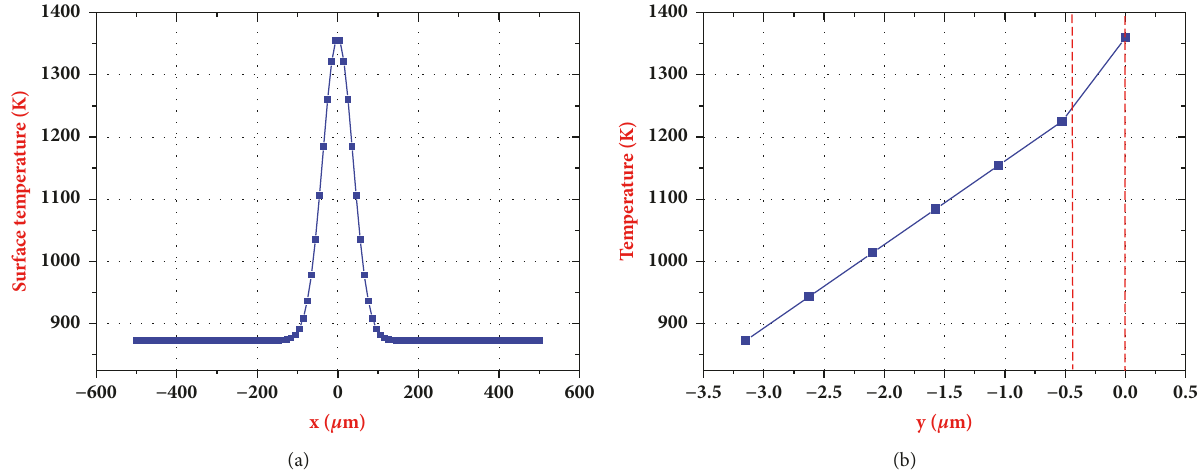
Figure 9: (a) Evolution of the temperature at the surface of Si 0.2 Ge 0.8 layer in the scan direction x and (b) longitudinal temperature changes of the sample at x = 0. The vertical lines delimit the area of Si 0.2 Ge 0.8